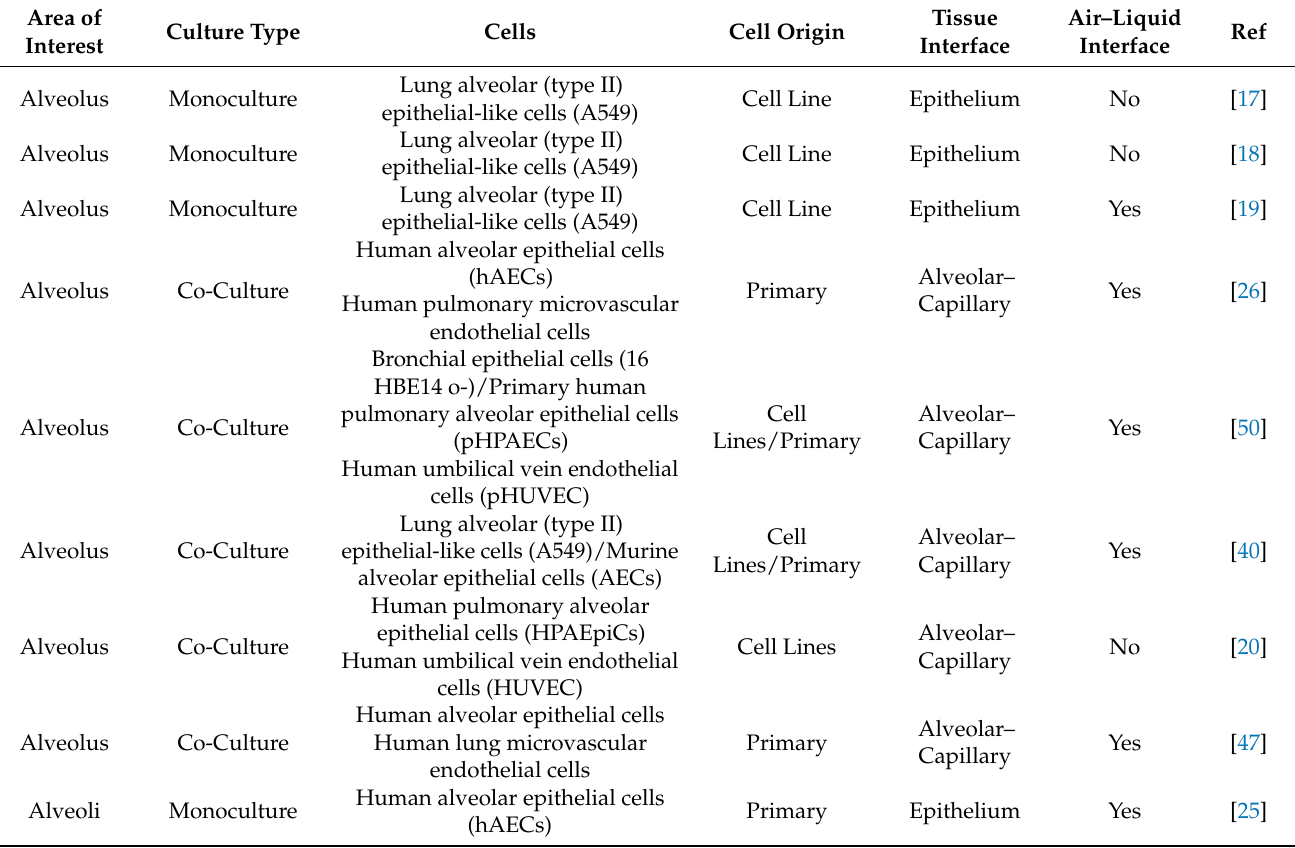
Table 1. Cellular Make-Up of Current Lung-On-A-Chip